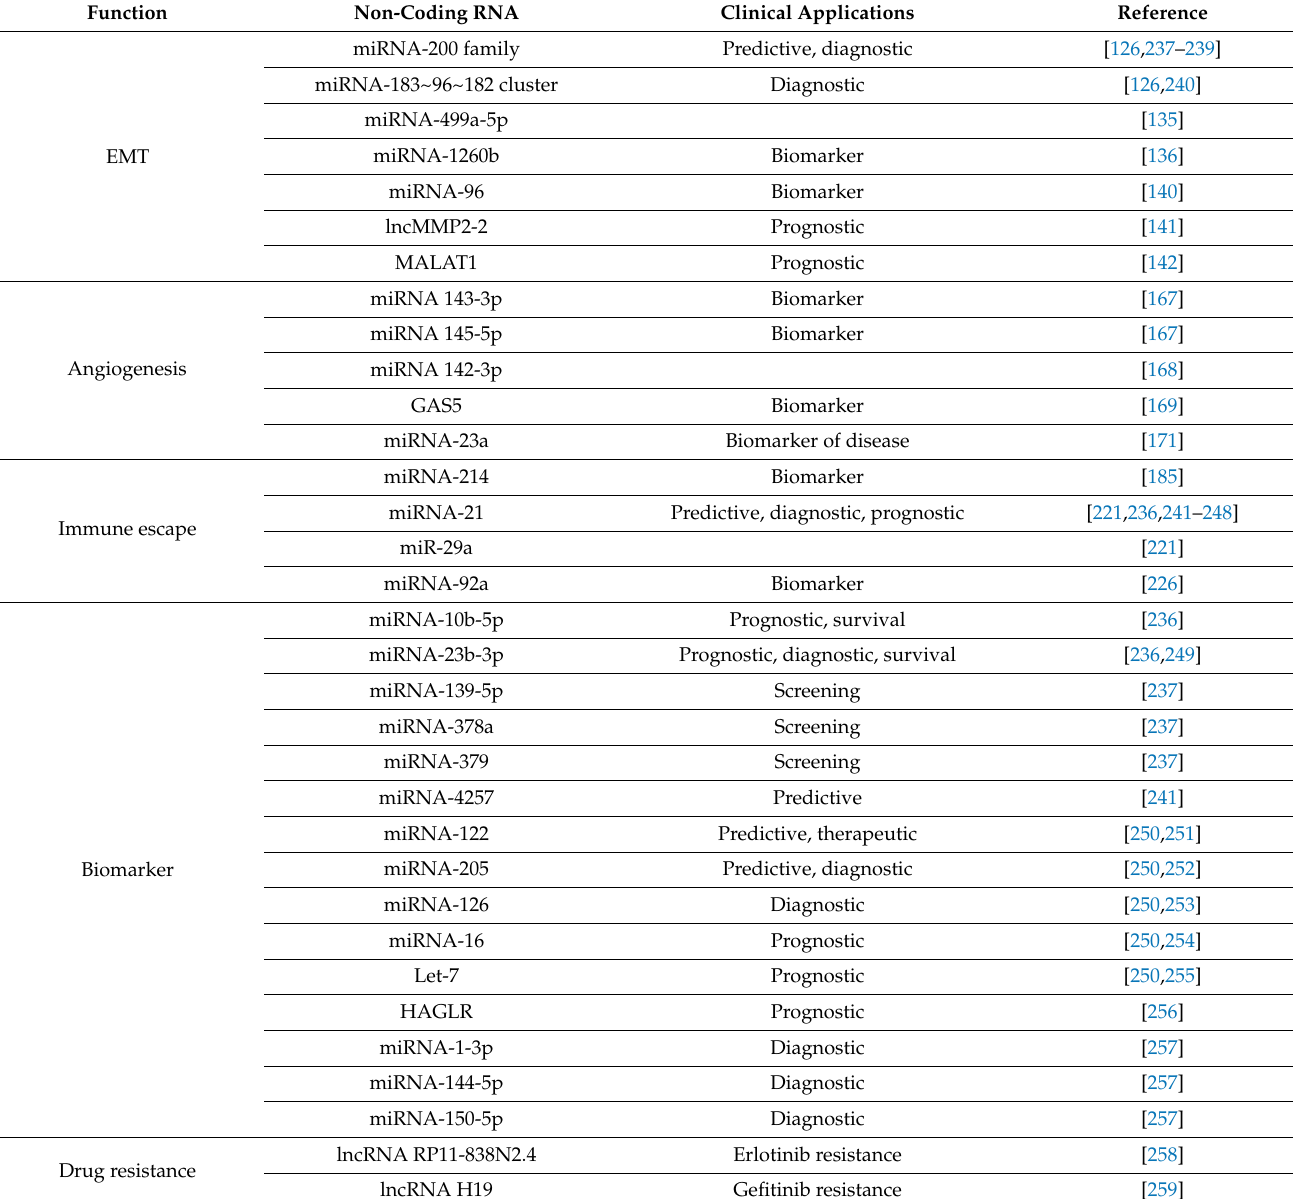
Table 2. Principal dysregulated non-coding RNAs and their clinical applications in lung cancer.